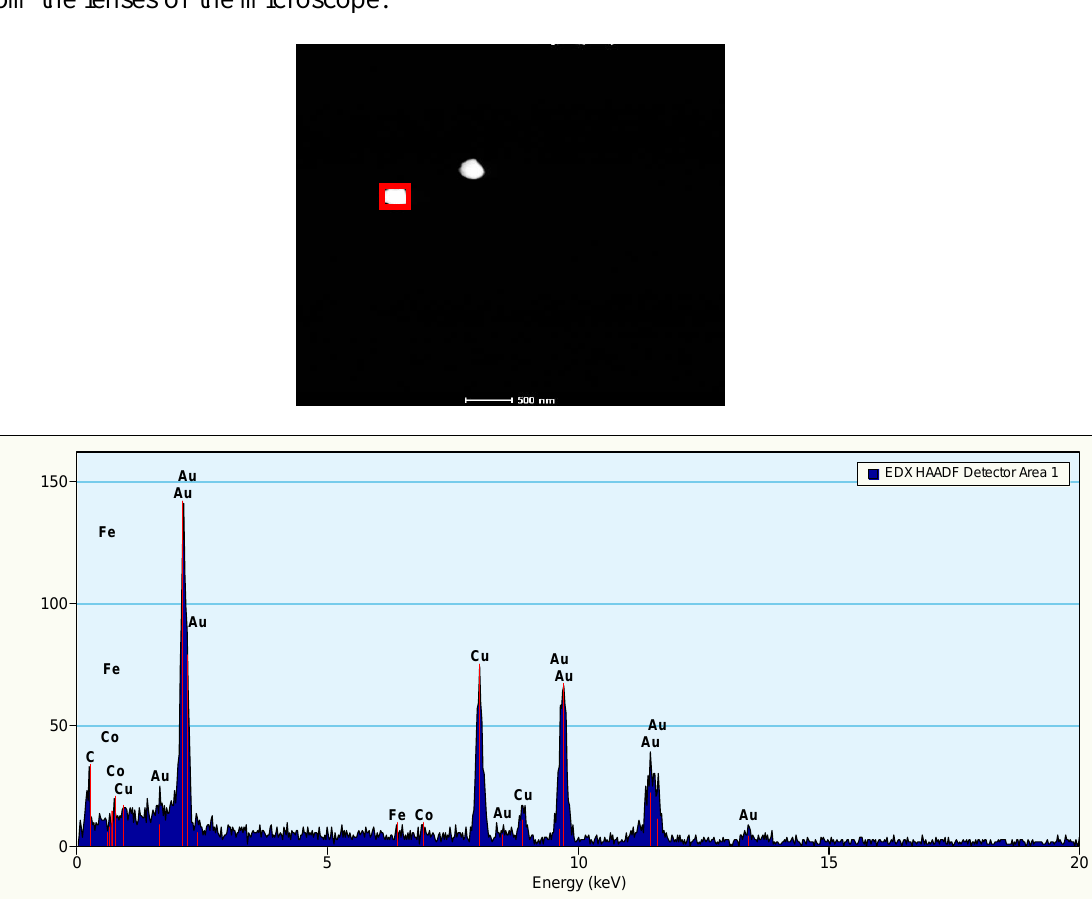
Figure 2. The presence of 250 nm gold nanoparticles in solution. Top: HAADF-STEM image depicting two Au-particles. The red rectangle indicates the region that was scanned during EDX acquisition. Bottom: EDX analysis of single 250 nm gold nanoparticle as present in the solution administered to the animals. In the graph the acquired spectrum of the marked area is presented. It is clearly visible that the particle consists of Au. The other signals in the spectrum can be explained: C, Cu: from the support grid and film, Fe, Co: from the lenses of the